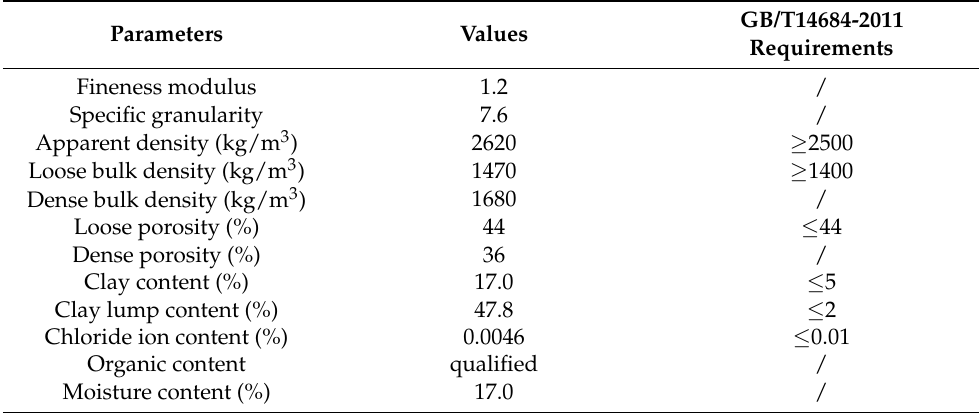
Figure 1. Appearance of sand used in this study: ( a ) SSTS; ( b ) M-S. Table 1. Physical properties of SSTS.